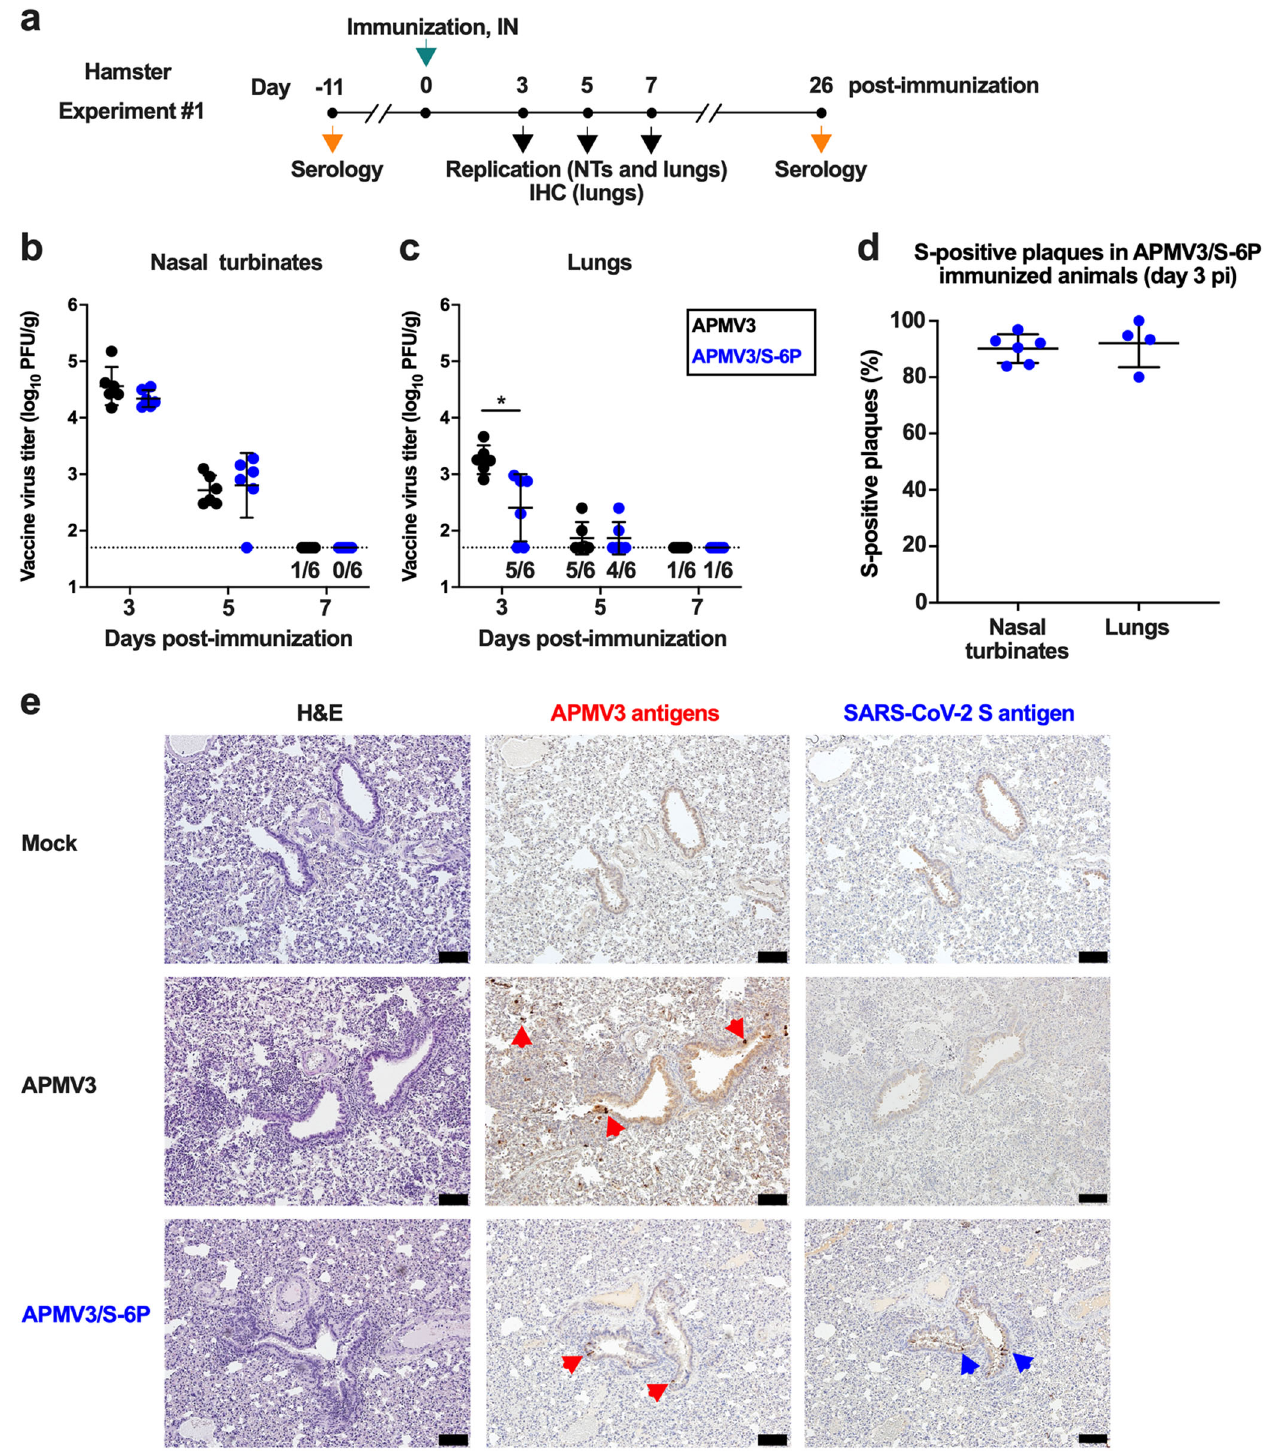
both viruses were lower by day 5. On day 7, only one animal from each group had virus detectable in the lungs, with titers at the limit of detection. The stability of S expression by APMV3/S-6P was evaluated by dual-staining immunoplaque assay from animals necropsied on day 3 pi with virus detectable by titration in respiratory tissues (NTs and lungs from six and four hamsters, respectively; Fig.